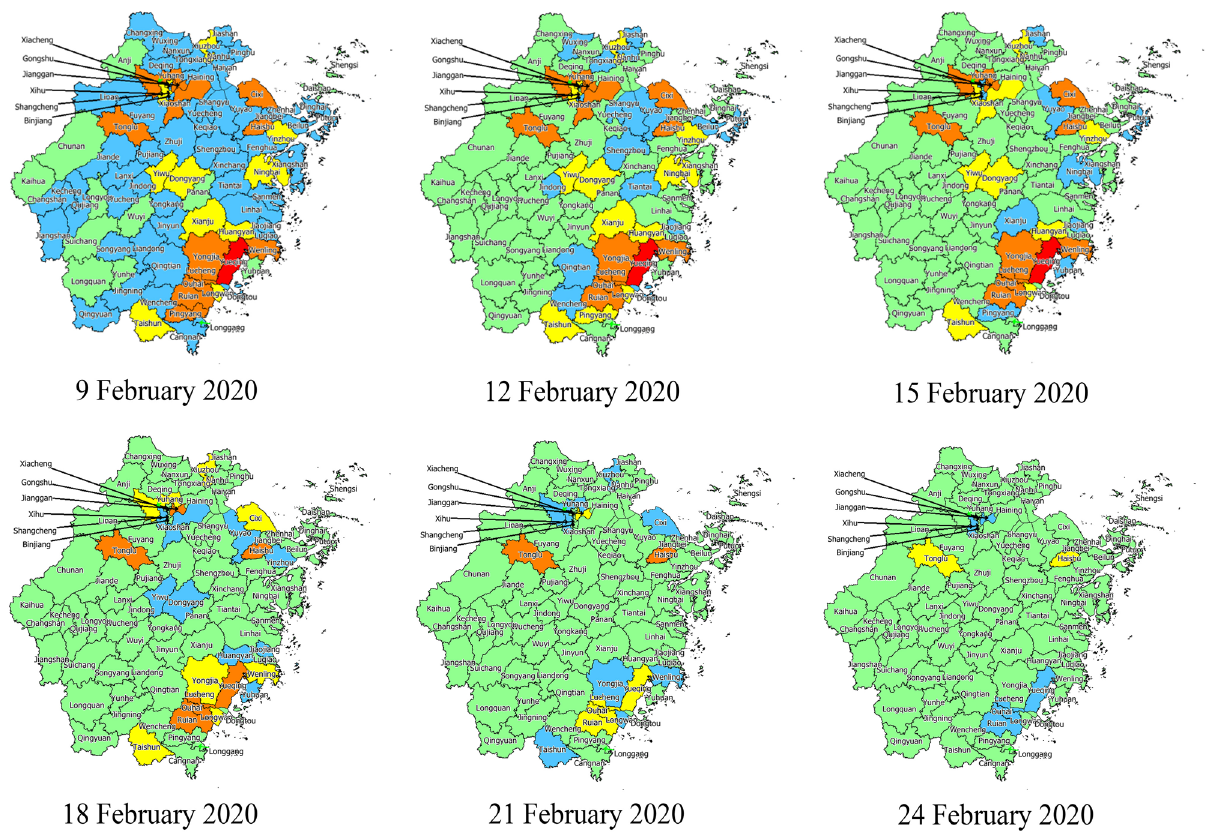
Figure 2. Five-colour epidemic charts of county-level epidemic risk in Zhejiang province from 9 to 24 February, 2020. Statement: The base map was provided by the Department of Natural Resources of Zhejiang Provincial (Map approval number: 浙 S(2020)17). We used the MapInfo software (V16.0 Chinese; URL link: https:// www. preci sely. com/ produ ct/ preci sely- mapin fo/ mapin fo- pro) to create the